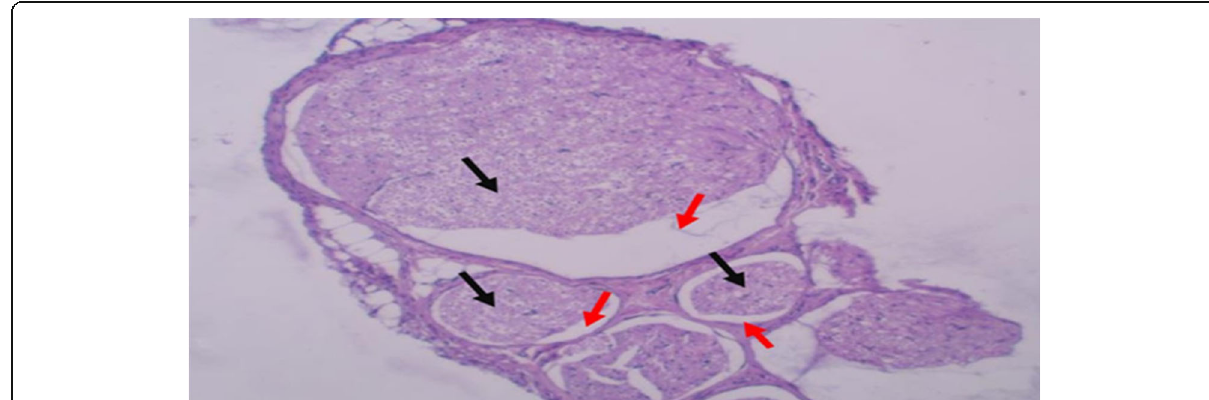
Fig. 4 Olfactory nerve (group 2) showing shrinkage of the nerve bundles within the perineural sheath, leaving empty spaces (red arrow) with evidence of edema within the nerve fibers (black arrow) (H&E